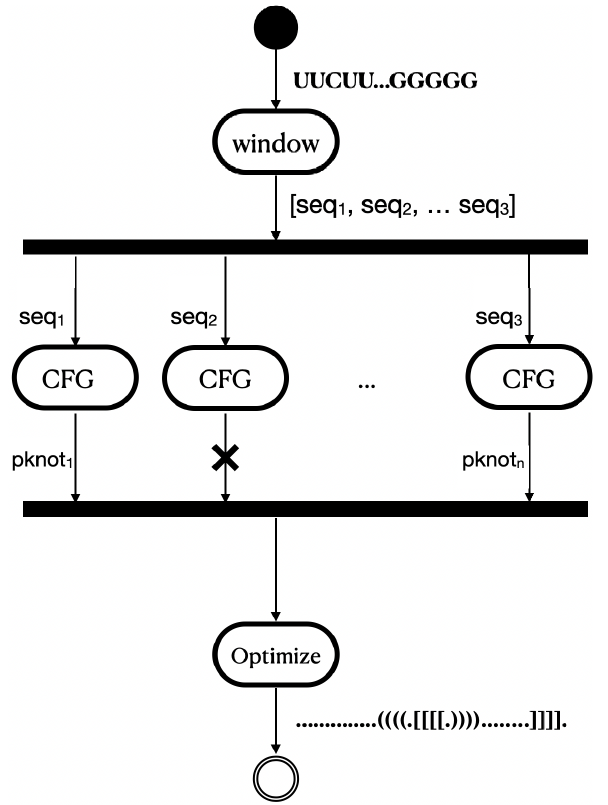
Figure 7. Pipeline